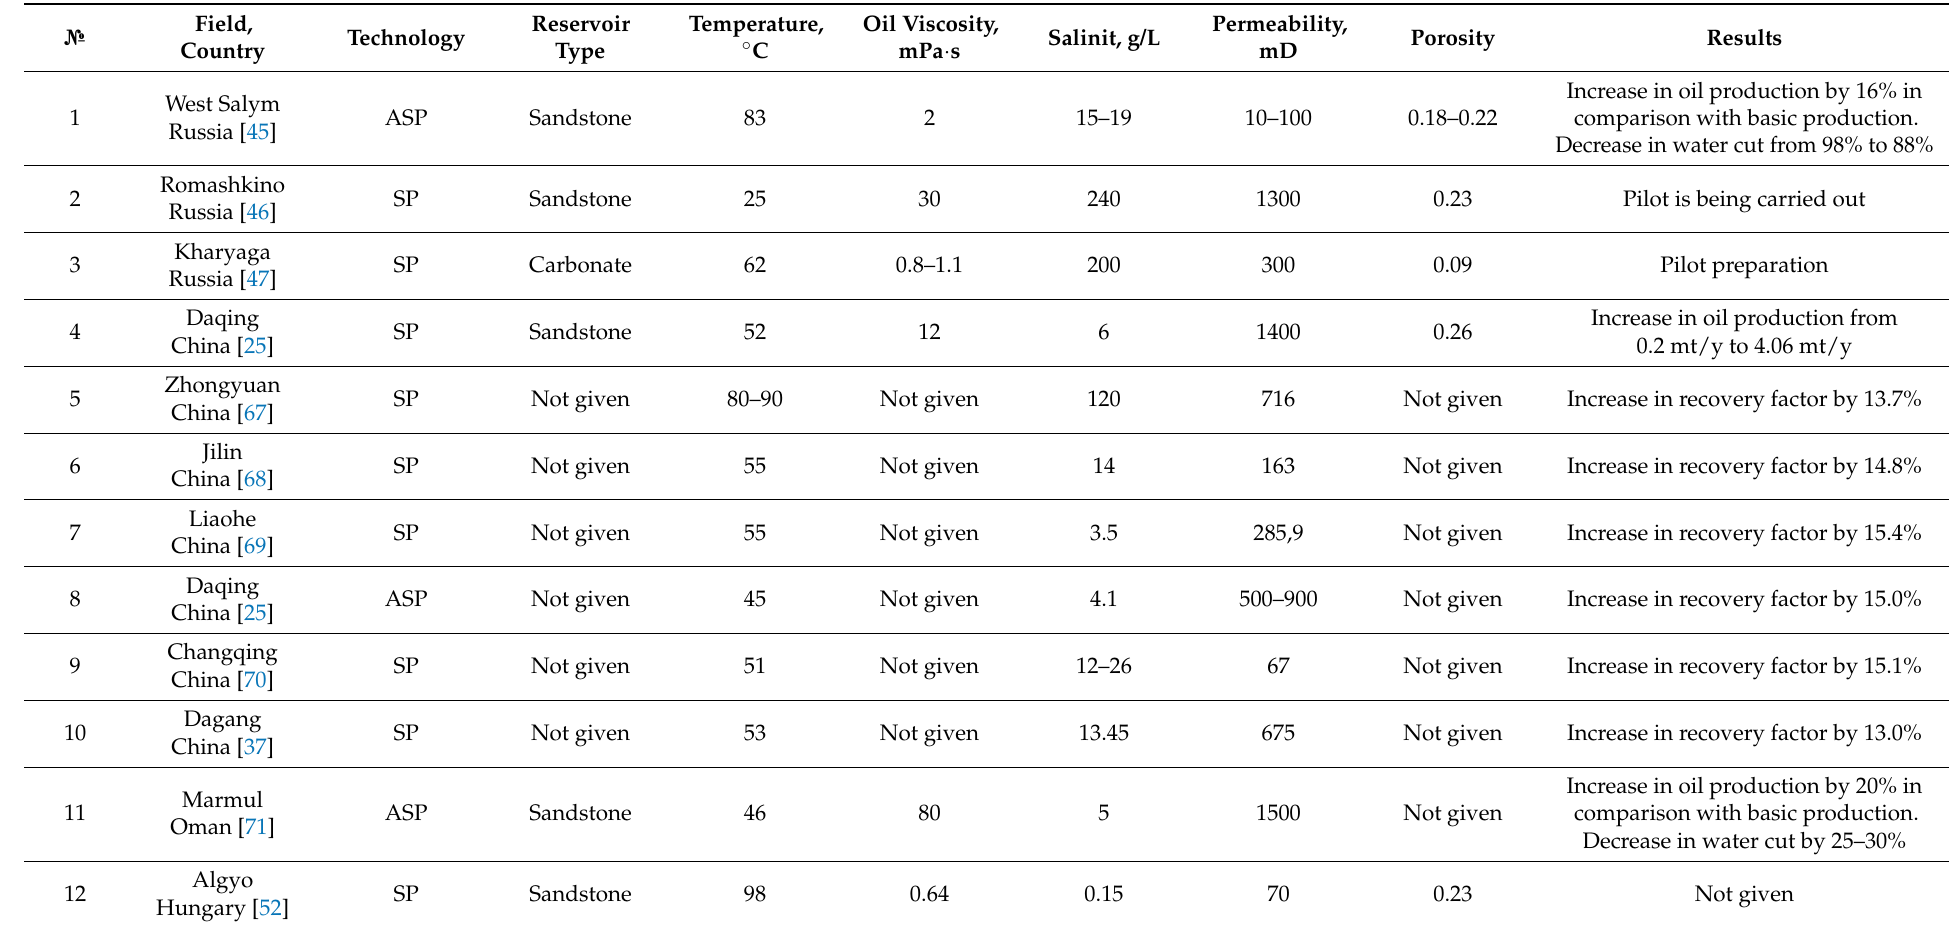
Table 2. Key characteristics of fields and brief results of the SP and ASP flooding